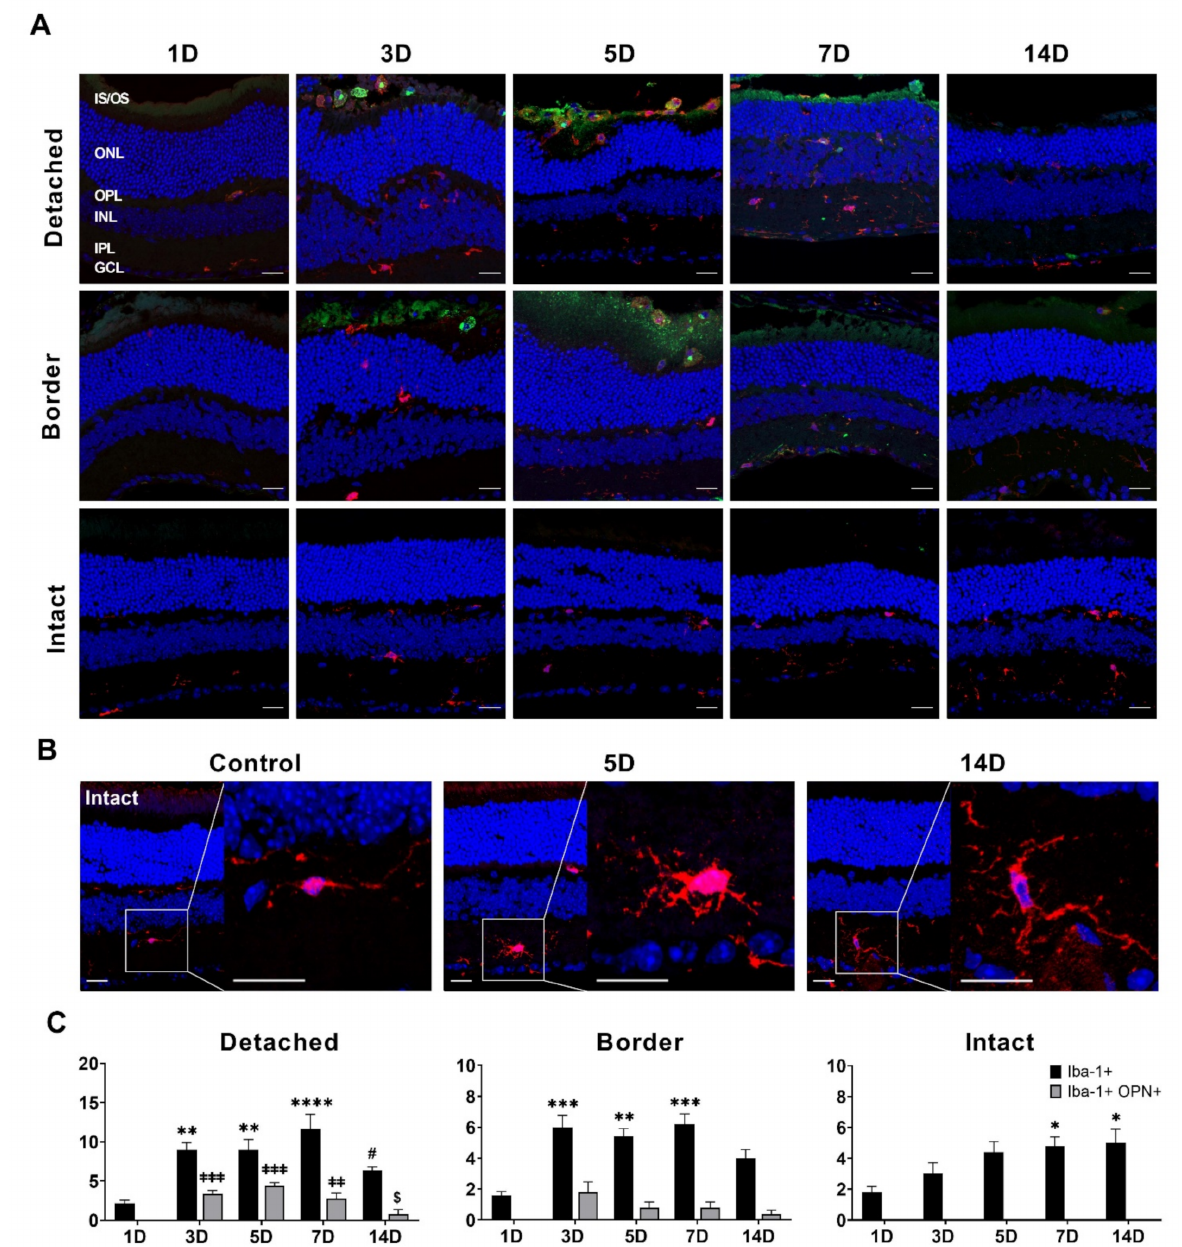
Figure 4. Iba-1 and OPN expression in mouse RD model. ( A ) Confocal micrographs of vertical cryosections collected 1, 3, 5, 7, and 14 days after RD. The sections were double immunostained with anti-Iba-1 (red) as a microglial cell marker and anti-OPN (green) as an inflammation marker. Iba-1 and OPN co-labeled microglial cells were mainly detected from 3 to 7 days after RD, and, thereafter, decreased by 14 days after RD in the detached and border regions. In the intact region, the number of Iba-1-labeled microglial cells was lower than that in the detached region, and OPN co-labeled microglial cells were undetected. OPN immunoreactivity was detected only in the subretinal space, but Iba-1 immunoreactivity was observed in all the layers. Scale bars, 20 µ m. ( B ) Representative Iba-1-labeled microglial cells at the normal control, peak, and end of the experiment in the intact region. Iba-1-labeled microglial cells showed changes in their morphological characteristics. Scale bars, 20 µ m. ( C ) Quantitative analysis of the number of Iba-1 and OPN co-labeled cells was conducted. In each region, the number of Iba-1- and OPN co-labeled cells were measured for all layers. Iba-1-labeled, and not OPN co-labeled, microglial cells were observed in each region. Most OPN co-labeled microglial cells were detected in the detached and border regions, but not in the intact region ( n = 6, 15 fields per time point). Data are shown as mean ± SEM. * p < 0.05, ** p < 0.01, *** p < 0.001, **** p < 0.0001, }} p < 0.01 and }}} p < 0.001 versus 1 day after RD, and # p < 0.05 and $ p < 0.05 versus 7 days after RD based on one-way ANOVA followed by Bonferroni’s multiple comparisons